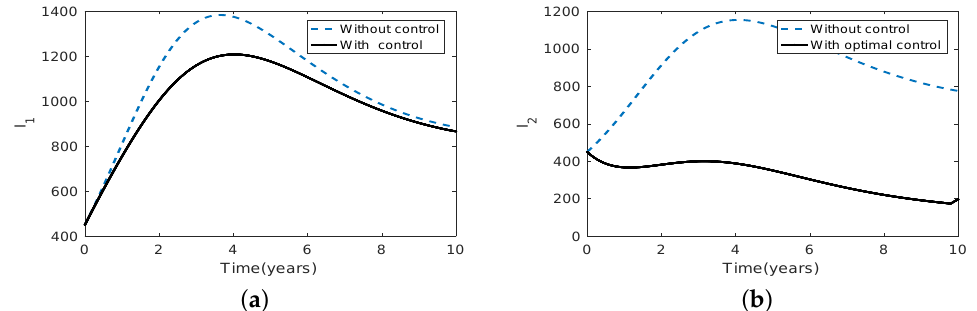
Figure 2. Simulation results of the proposed two patch brucellosis model for scenario 1 under strong symmetric coupling ( a ) the numbers of infected animals in patch 1 ( b ) the numbers of infected animals in patch 2. In all the figures the dotted blue and solid black curves represent the infected population, without and with control, respectively.